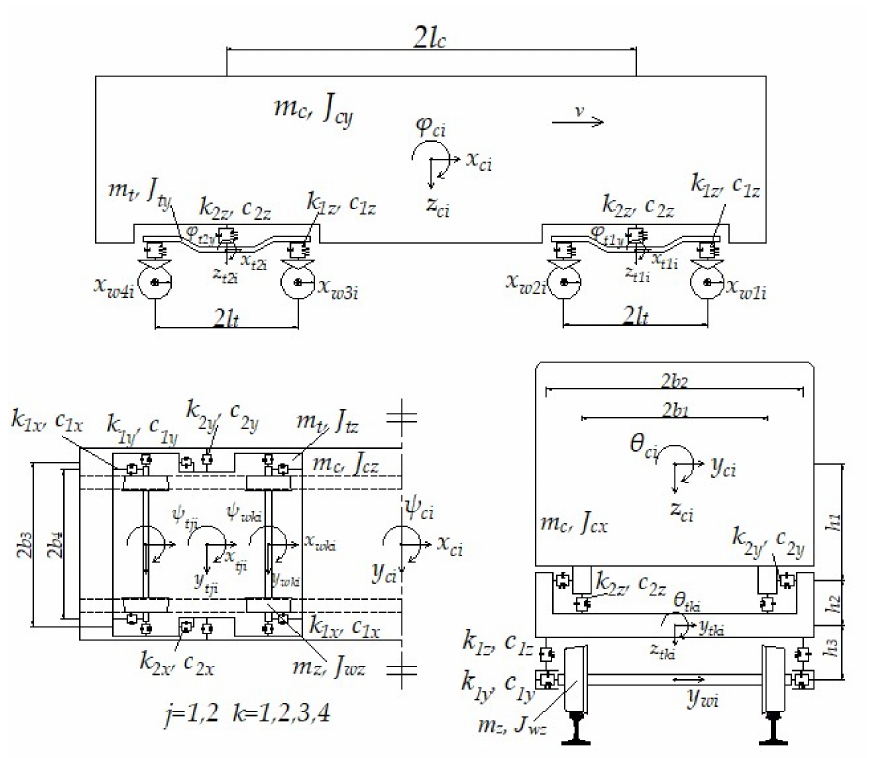
Figure 2. Illustration of the 3D high-speed railway vehicle model developed in this study. The total potential energy of train inertia forces includes individual potential energy associated with inertia forces (e.g., car body, front and rear bogies, and four wheel-sets), elastic strain of linear springs, damping forces of dashpots (e.g., primary and secondary suspension systems), and the potential gravitational energy of the whole vehicle (e.g., car body, front and rear bogies, and four wheel-sets). According to the principle of conservation of the total potential energy of dynamic elastic system [25], the multi-body dynamics (MBD) based matrix expression of the governing equation of spatial train vibration (see Equation (1)) was obtained by using the “right number seating” rule